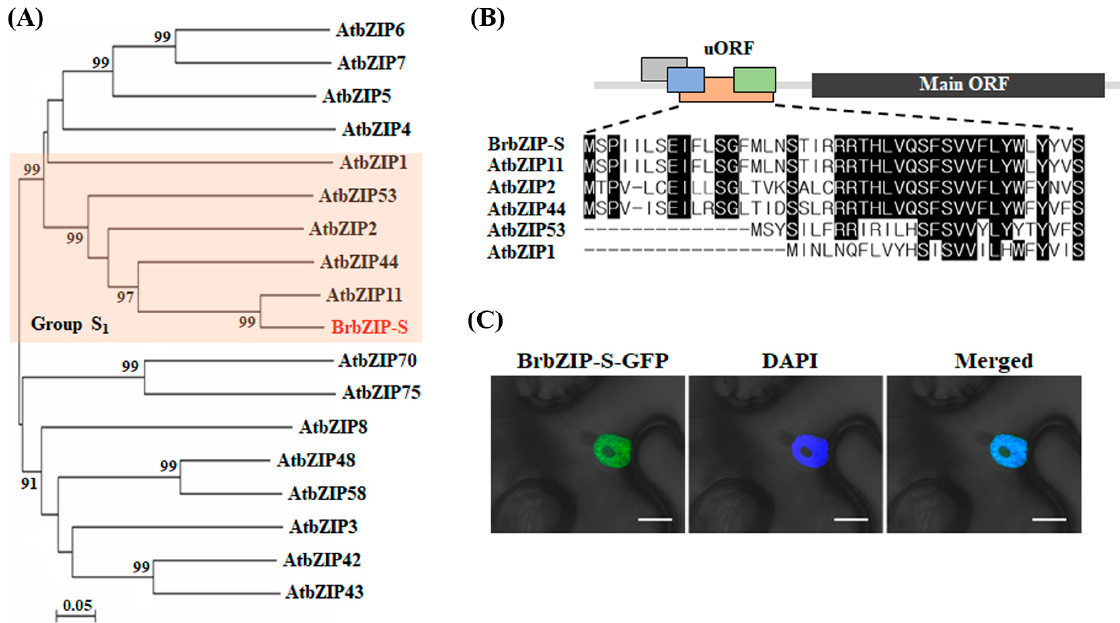
Figure 1. Characterization of Brassica rapa bZIP-S (BrbZIP-S). ( A ) Phylogenetic analysis between Arabidopsis S bZIPs and BrbZIP-S. ( B ) Evolutionary conserved uORF in BrbZIP-S. The predicted amino acid sequence encoded by SC-uORF of BrbZIP-S was aligned with Arabidopsis S 1 -bZIPs. ( C ) Subcellular localization of BrbZIP-S in N. benthamiana plants. Co-localization of GFP with DAPI confirms the localization of BrbZIP-S in the nucleus. Scale bar = 10 μ m.